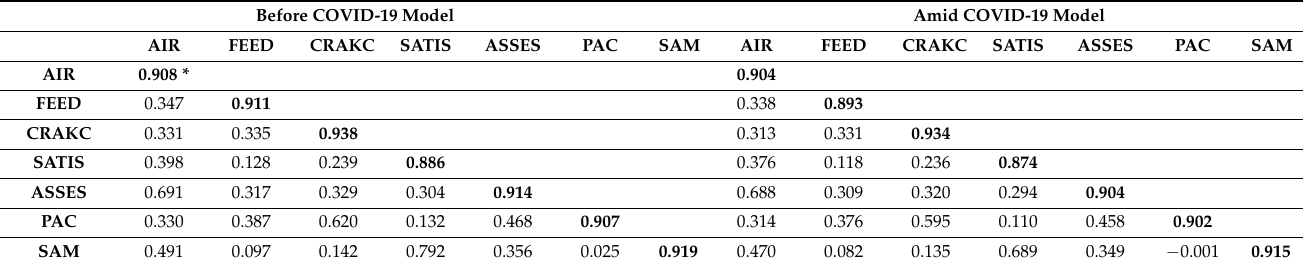
Table 2. Validity